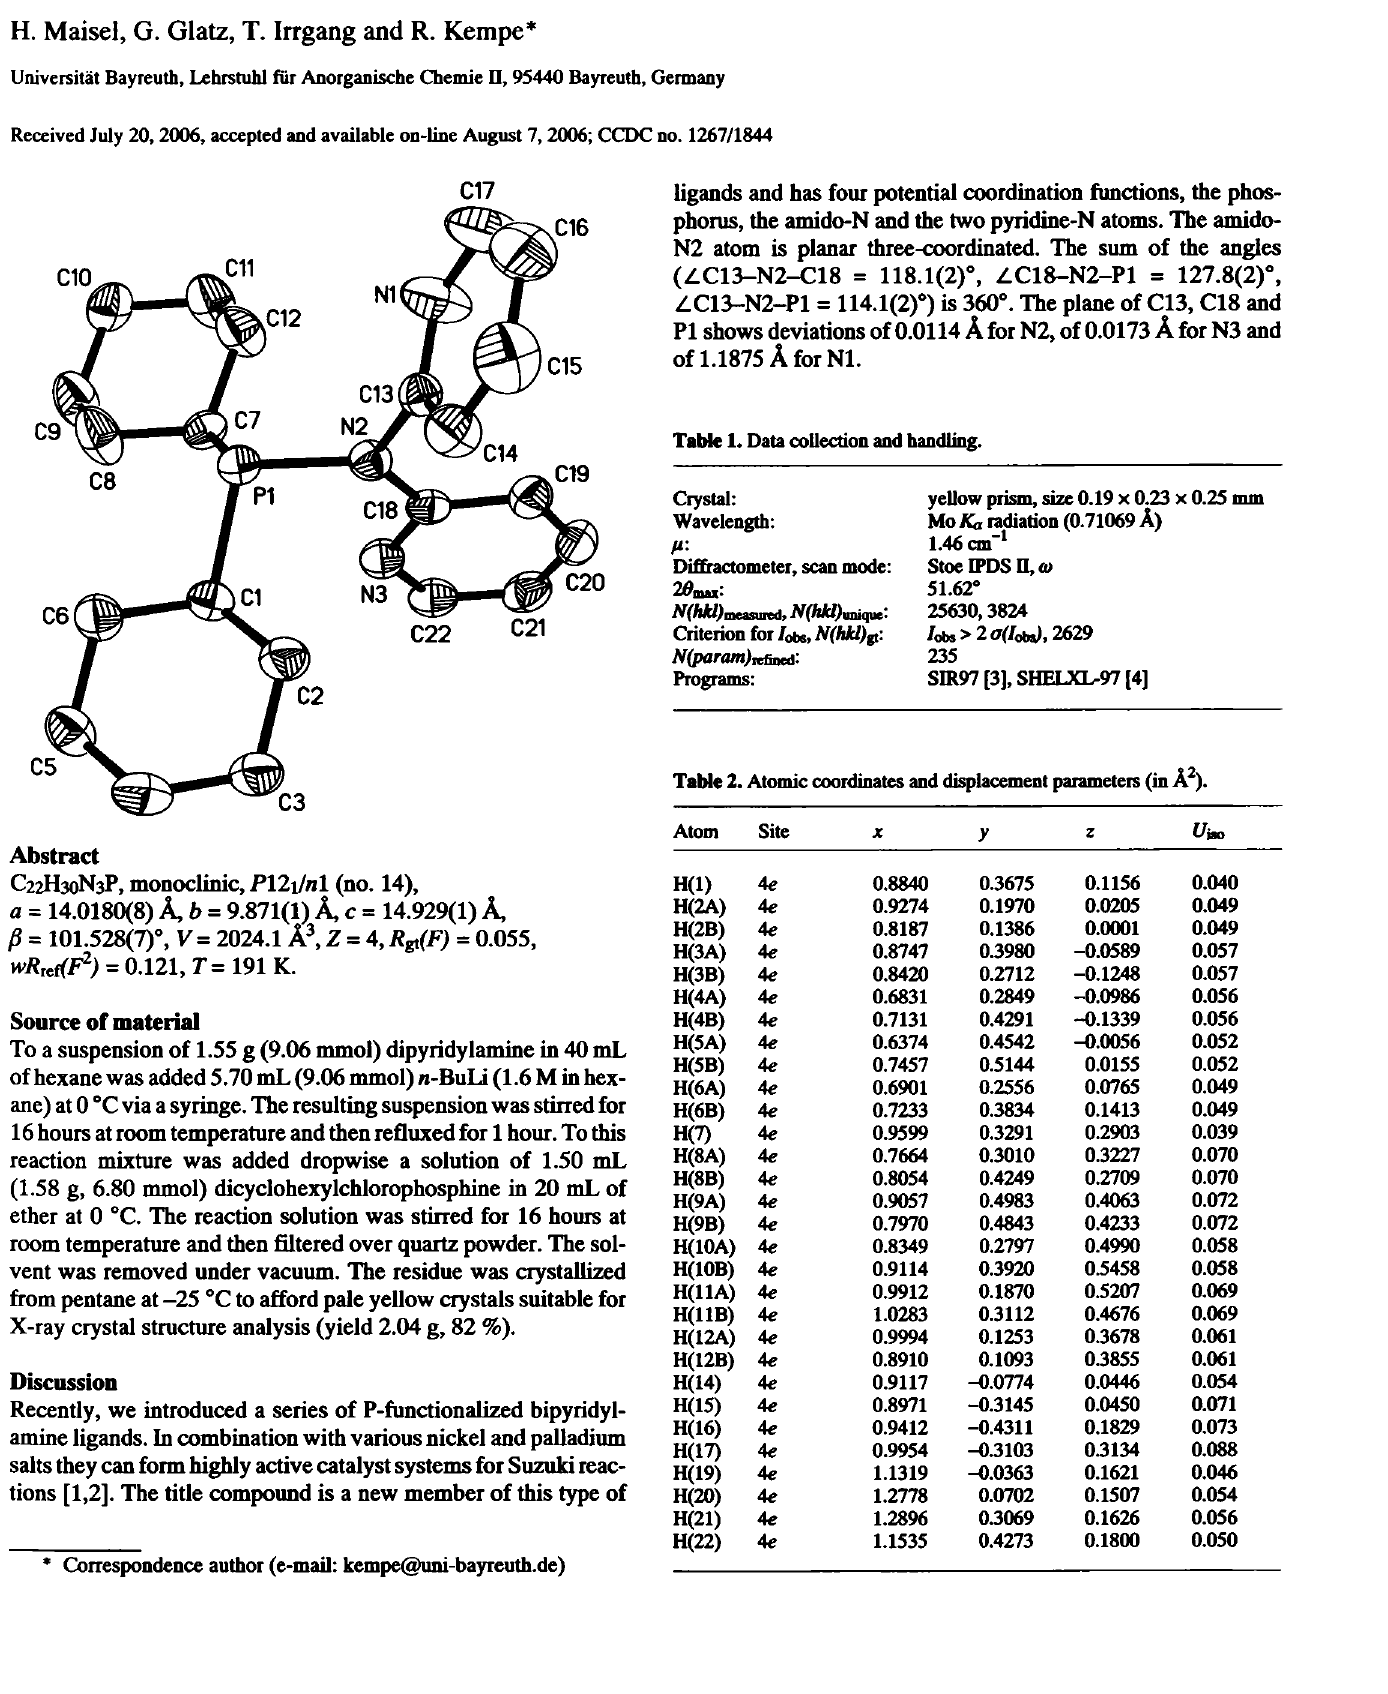
Table 1. Data collection and handling. Crystal: Wavelength: ft- Difiractometer, scan mode: